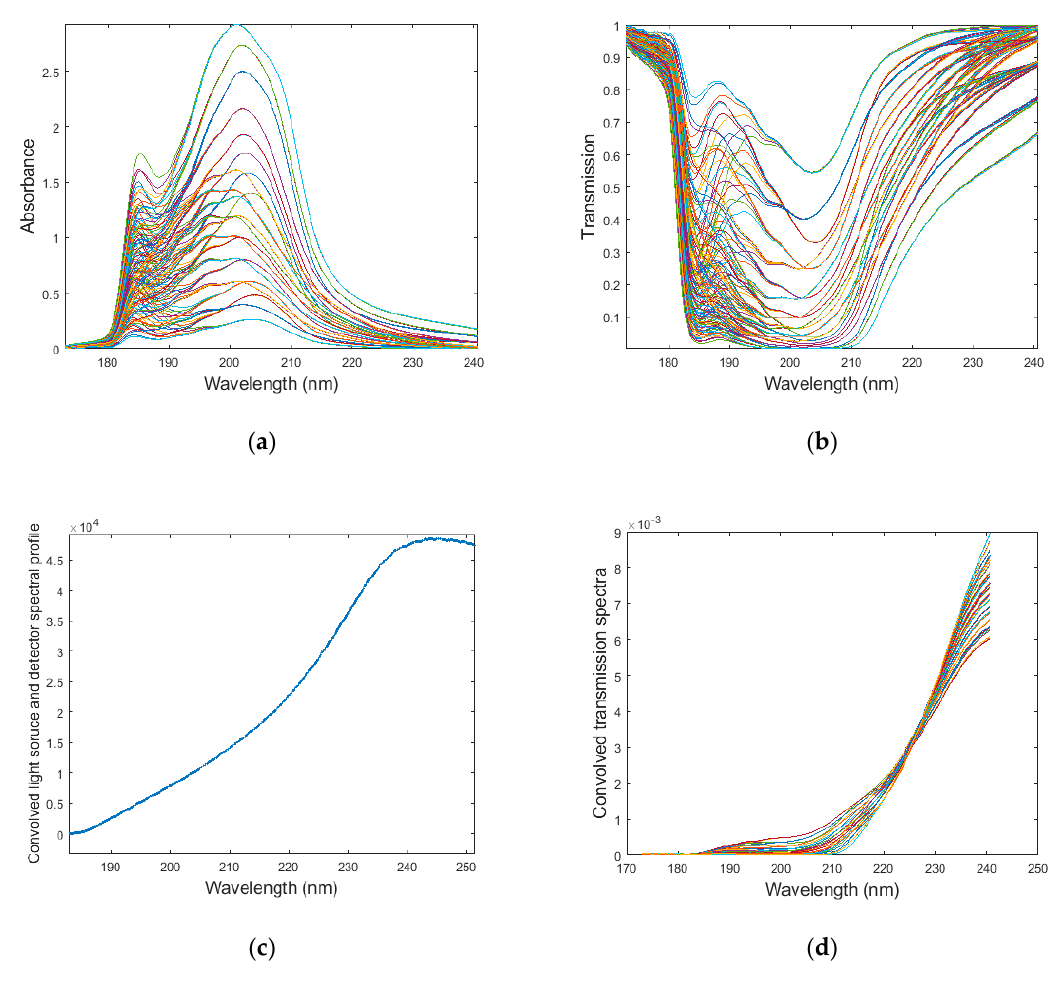
Figure 5. ( a ) UV absorbance spectra of H 2 S and CH 4 SH mixtures (H 2 S concentration varies from 7 nmol/mL to 141 nmol/mL); ( b ) UV transmission spectra of H 2 S and CH 4 SH mixtures; ( c ) convolved spectral profile of light source and detector; ( d ) system spectral profile convolved transmission spectra of samples.